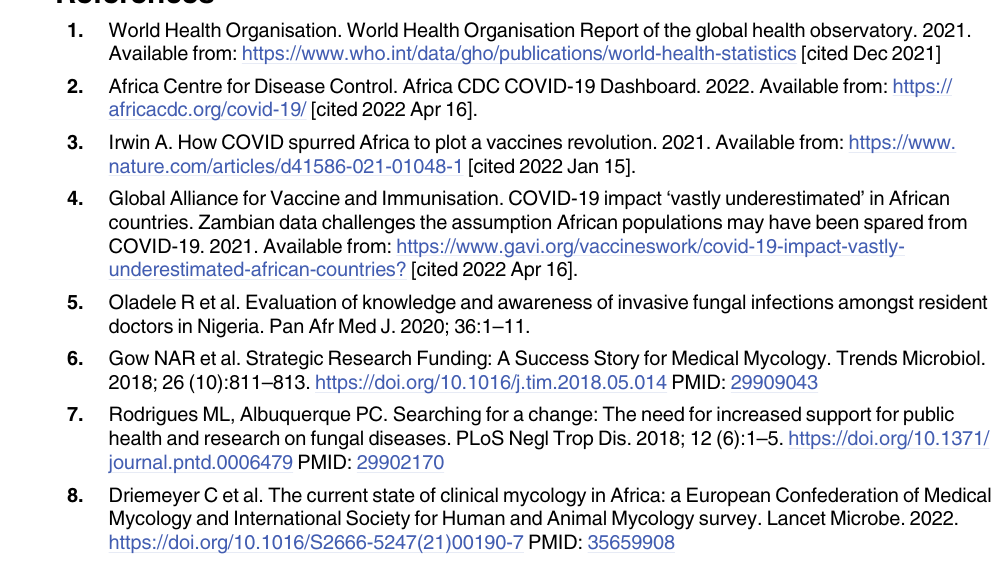
S1 Table. The population and some characteristics of African